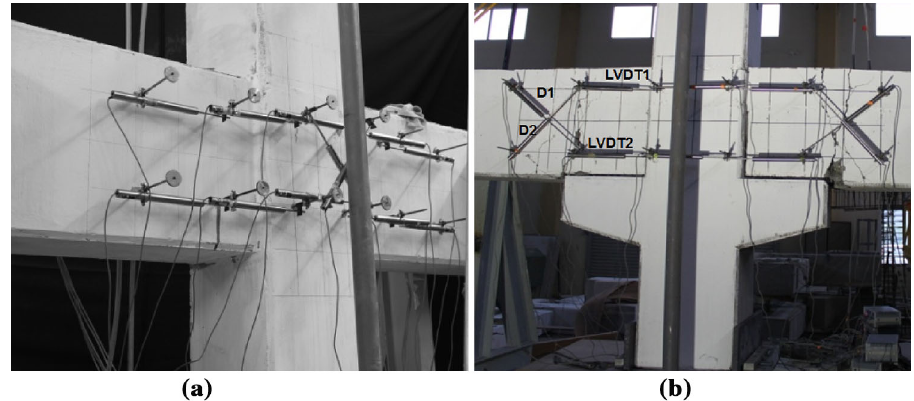
Fig. 12 Installation of LVDTs for a MONO, SP1-R, SP3 and b SP1, SP2, and SP3-R specimens.